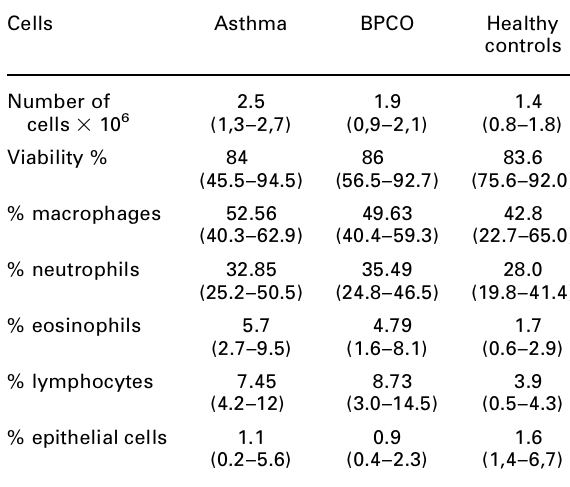
Table 2. Subjects’ cell